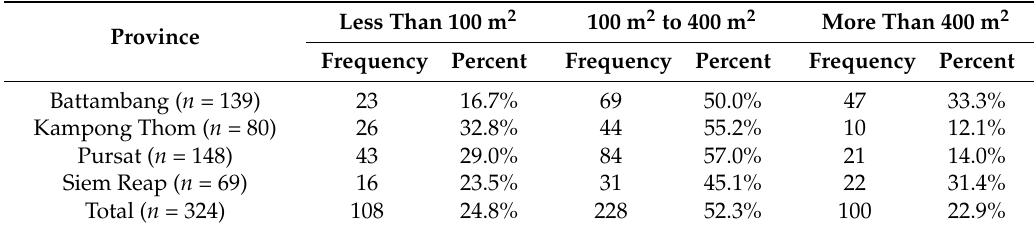
Table 4. Households, by province and size of fish